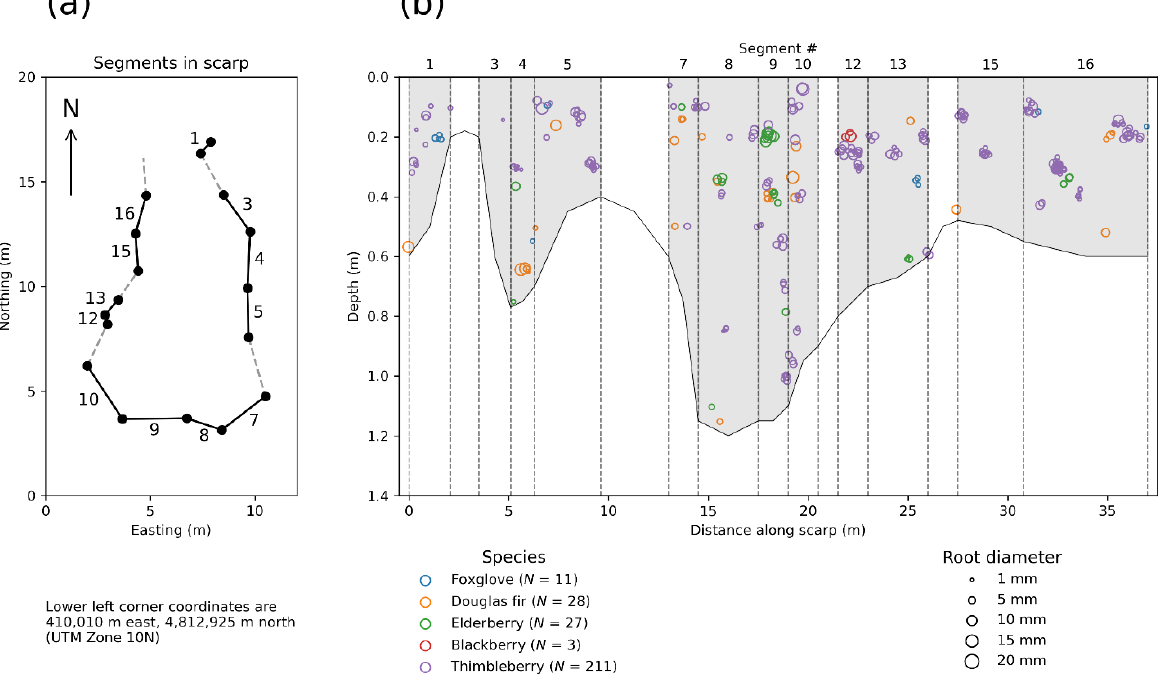
Figure 4. Panel ( a ) shows the plan view of the landslide scarp perimeter constructed with a tape and compass survey, showing the locations of numbered segments. Only segments where roots were measured are numbered. Segments where no roots were measured (because of obstructions including collapsed soil masses and broken site infrastructure) are shown as dashed lines. Segments of scarp perimeter are constrained to the boundary of the initial landslide and do not include the downslope debris-flow. Data on the location of the scarp segments are available in Schmidt and Cronkite-Ratcliff [35]. Panel ( b ) shows the location and diameter of live roots in the scarp, showing the depth below ground surface and the position along the landslide scarp perimeter for each root. The vertical dashed lines demarcate the lateral boundaries of each segment along the scarp perimeter, with shaded areas showing the approximate areal extent of each scarp segment. A small amount of “jitter” (Gaussian noise with variances of 0.1 m and 0.01 m in the horizontal and vertical dimensions, respectively) has been applied to the location and depth to visually differentiate roots located at the same perimeter and depth location. Data on the location and diameter of roots are available in Schmidt and Cronkite-Ratcliff [35].